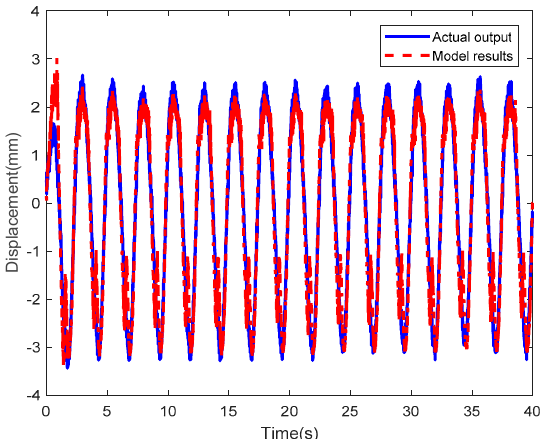
Figure 21. Results of the LSSVM ‐ NARX model at sinusoidal actuating voltage with Figure 22. Results of the LSSVM-NARX model at sinusoidal actuating voltage with amplitude of 2V amplitude of 2V and frequency of 1/2 π Hz. and frequency of 1 / 2 π